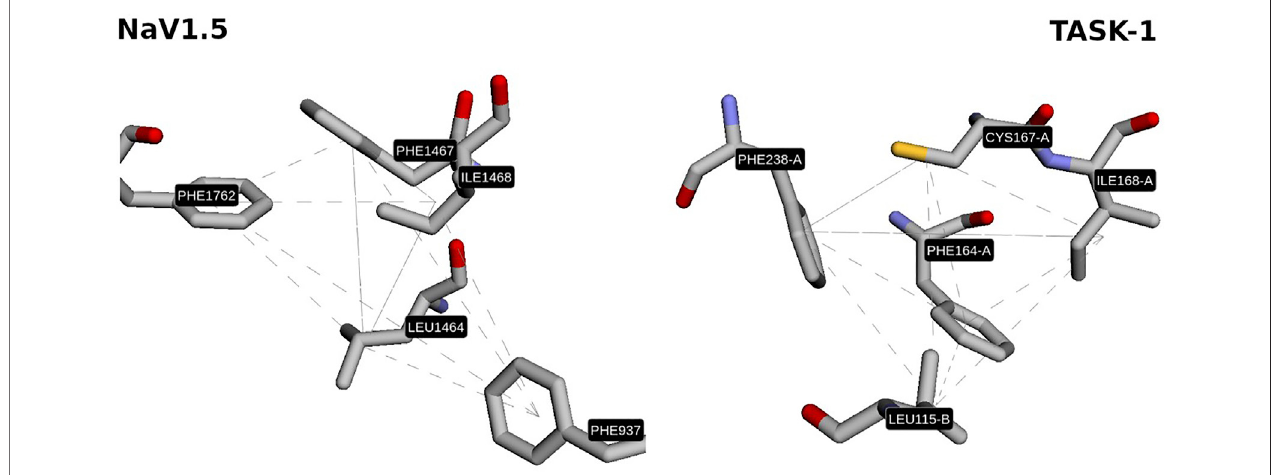
FIGURE 6 | Similar 3D pattern found in NaV1.5 and TASK-1. In both sites, the residues PHE1762 and PHE238 show similar orientation.